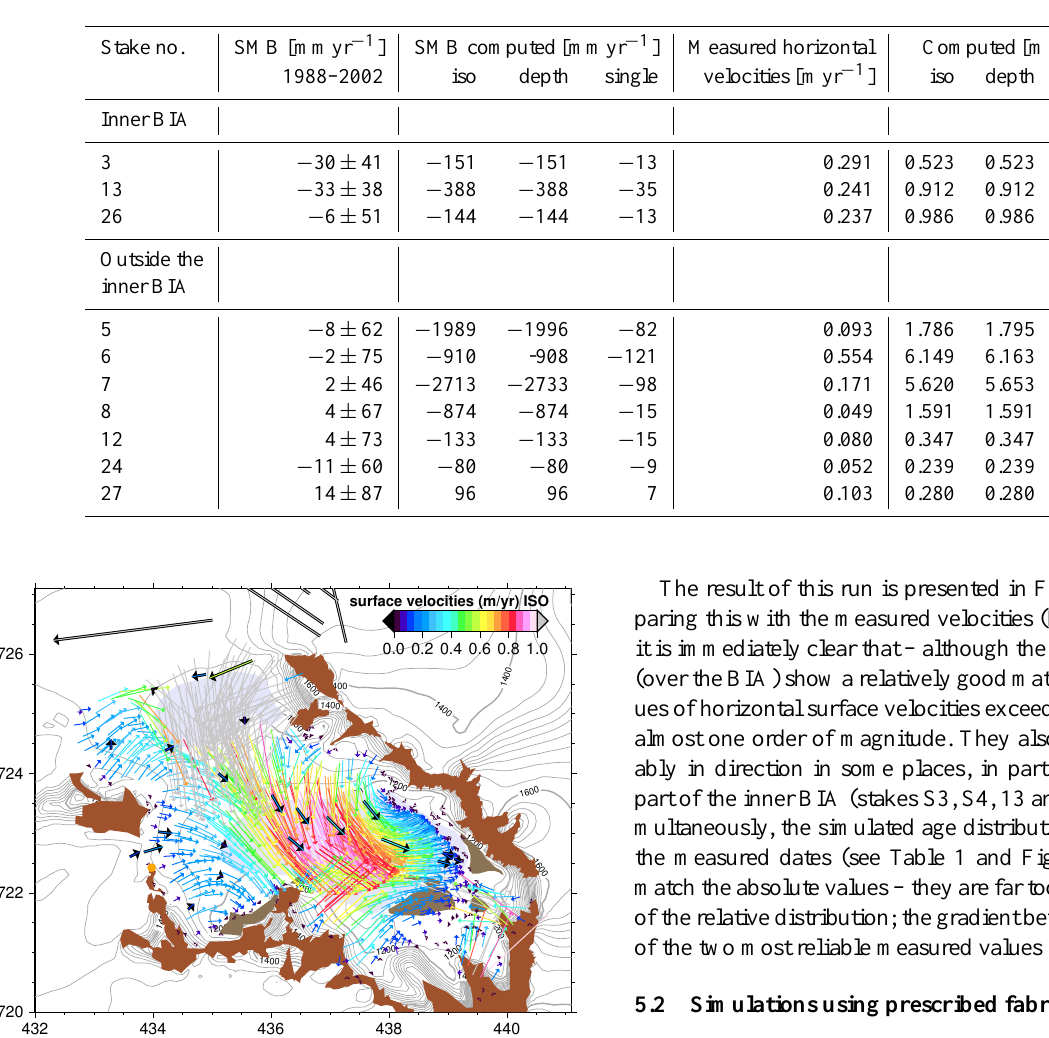
Table 3. Measured (Sinisalo et al., 2003) and computed steady-state surface mass balance in mma − 1 w.e. and comparison between measured and computed surface velocities for the isotropic (iso), depth-dependent (depth) and the single vertical maximum (single) fabric. Compare stake positions with Fig. 1.